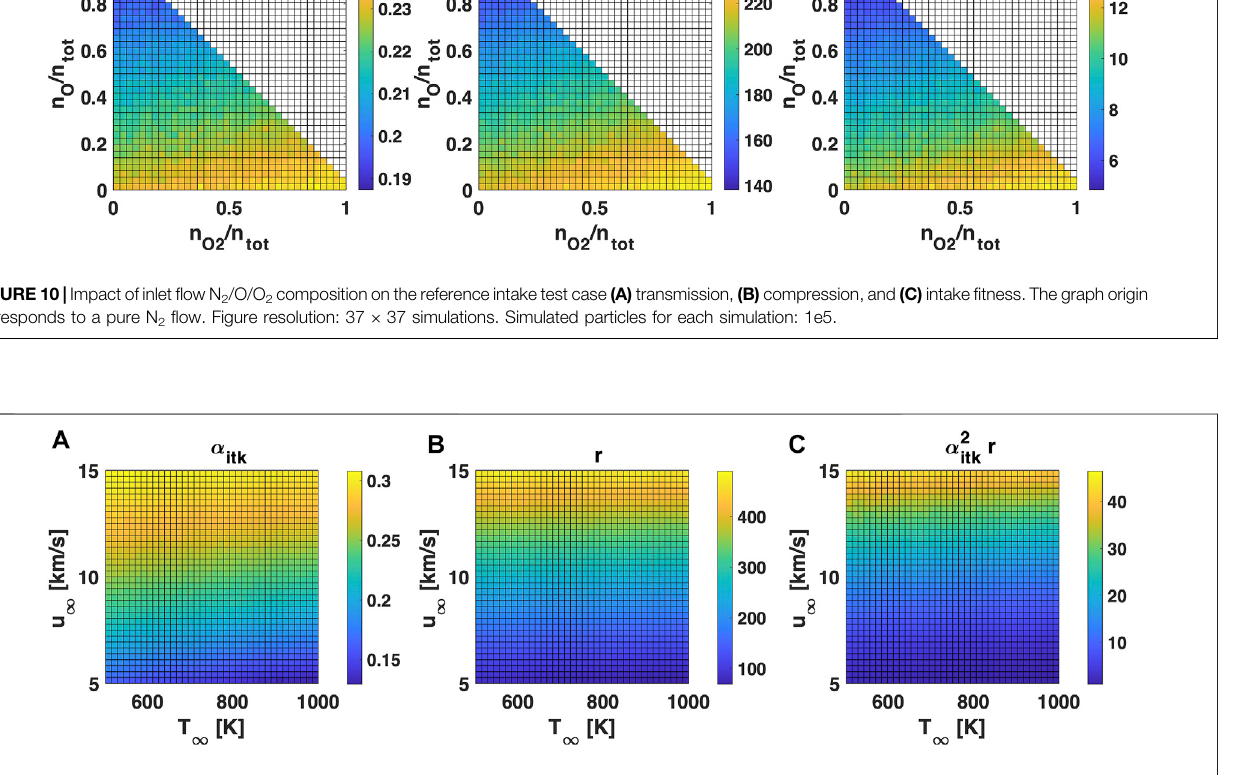
FIGURE11| Impactofinlet fl owvelocityandtemperatureonthereferenceintaketestcase (A) transmission, (B) compression,and (C) intake fi tnessfora50/50N 2 / O composition. Figure resolution: 37 × 37 simulations. Simulated particles for each simulation: 1e5.